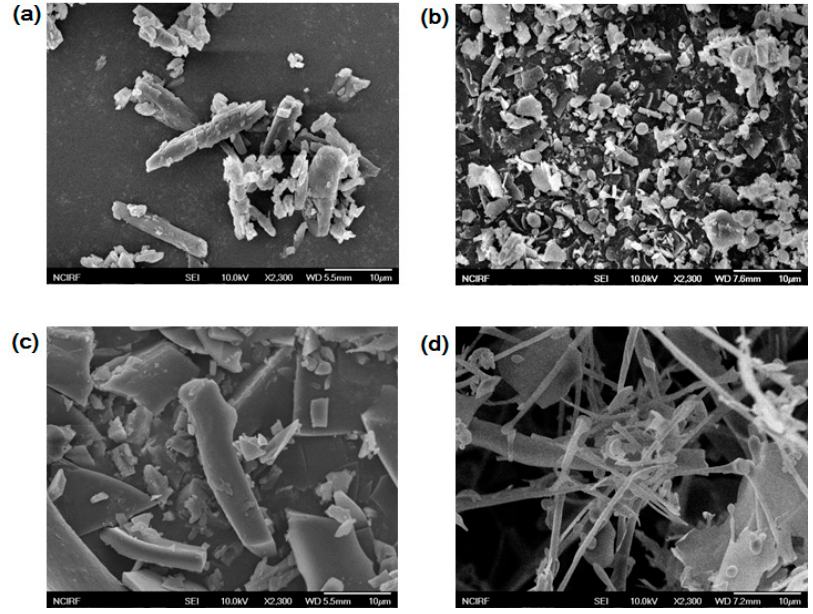
Figure 6. SEM photographs. ( a ) Baicalein; ( b ) Cysteinyl β -CD; ( c ) Physical mixture; ( d ) Cysteinyl β -CD/baicalein inclusion complex.